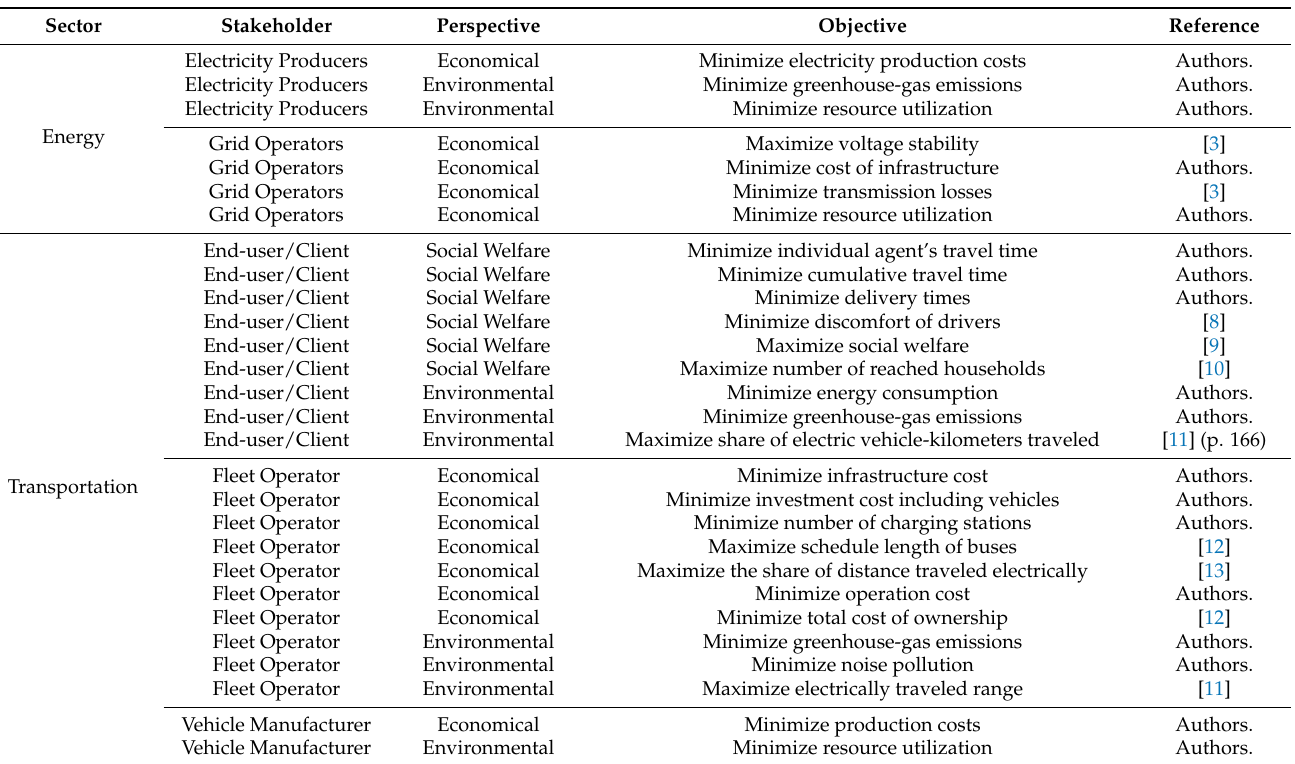
Table 1. Overview of stakeholders in the energy and transportation sectors and their different optimization objectives from economic, environmental, and social welfare